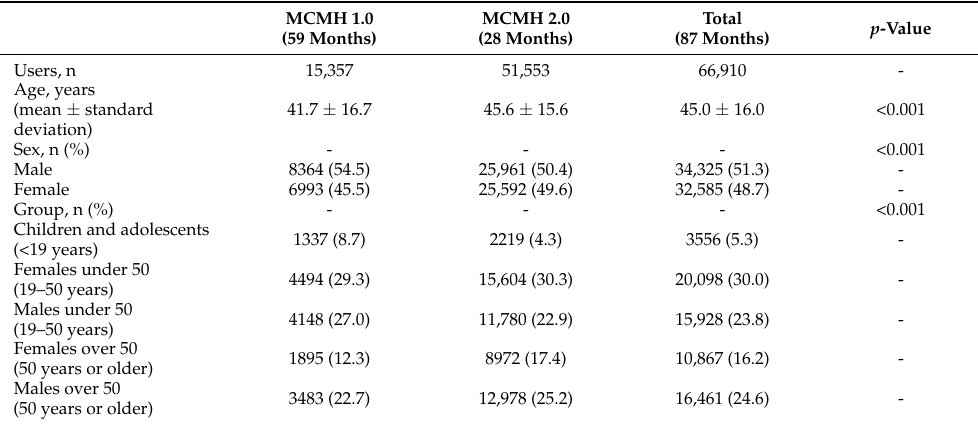
Table 2. Demographic profiles of the users of My Chart in My Hand (MCMH) according to age and sex.